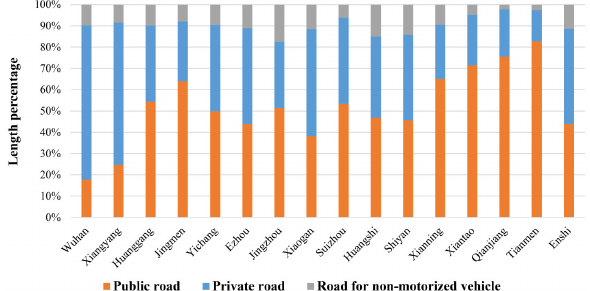
Figure 6. Length percentages of omission roads in the 16 prefecture-level divisions of Hubei (China), in terms of the three road types, i.e. public road, private road, and road for non- motorized vehicles